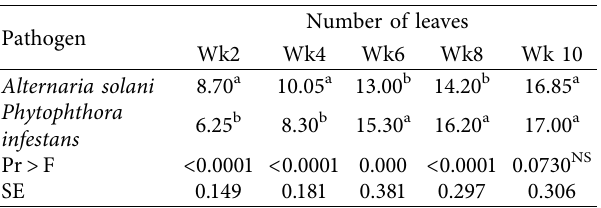
Table 4: Effect of the test pathogens on the leaf number of tomato